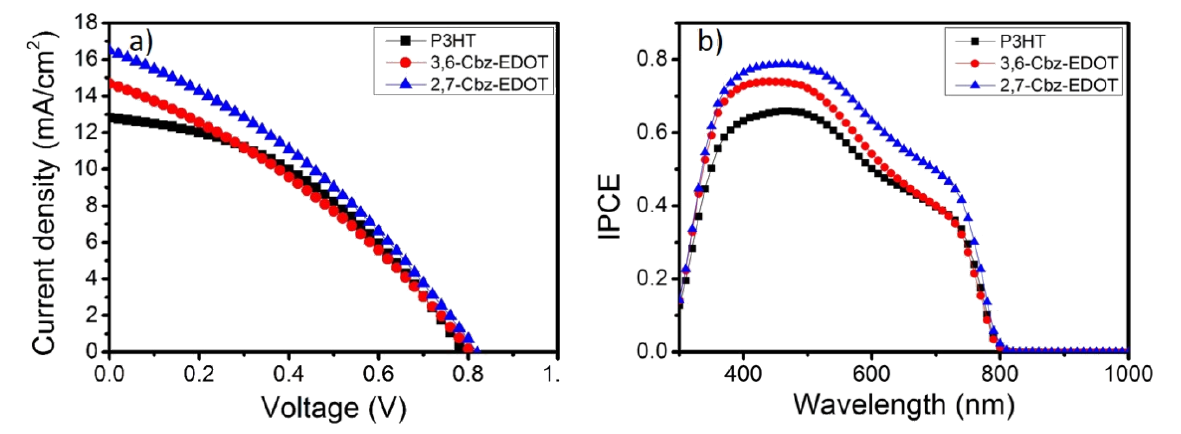
Figure 3: (a) Current density–voltage curves and (b) incident photon to current conversion efficiency (IPCE) spectra for PSCs with different HTMs under AM1.5G illumination at 100 mW cm − 2 .